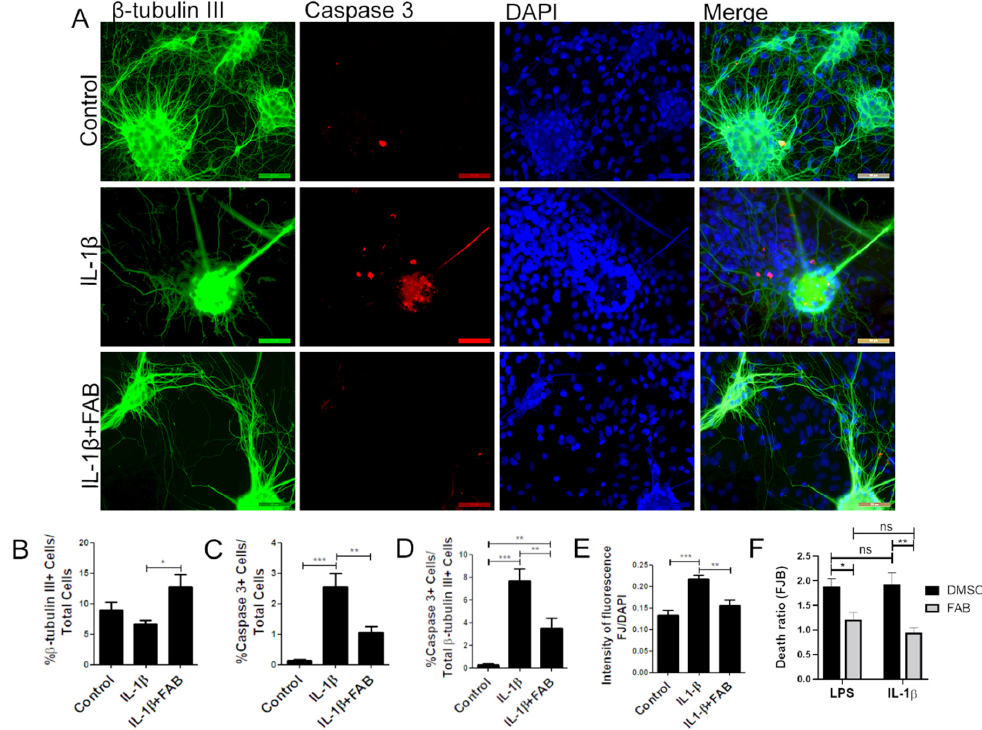
Figure 4. Agathisflavone protects neurons against neuroinflammation induced by interleukin (IL)-1 β . ( A ) Representative photomicrographs of immunofluorescence labeling for the apoptotic marker caspase-3 (red), the neuronal marker β -TubIII + (green), and nuclear stain DAPI (blue); scale bar: 50 µ m. ( B – F ) Bar graphs showing the percentage of β -TubIII + , caspase-3 + cells, and β TubIII + / caspase-3 + cells in each condition ( B – D ), together with the proportion of neurons undergoing degeneration measured by the FJ-B/DAPI fluorescence intensity stain after IL-1 β and FAB ( E ) and comparing FAB with LPS and IL-1 β ( F ); values are expressed as the mean ± SEM ( n = 3) and were tested for significance by two-way ANOVA followed by Bonferroni’s post-test. *** p < 0.001, ** p < 0.01, and * p < 0.05.